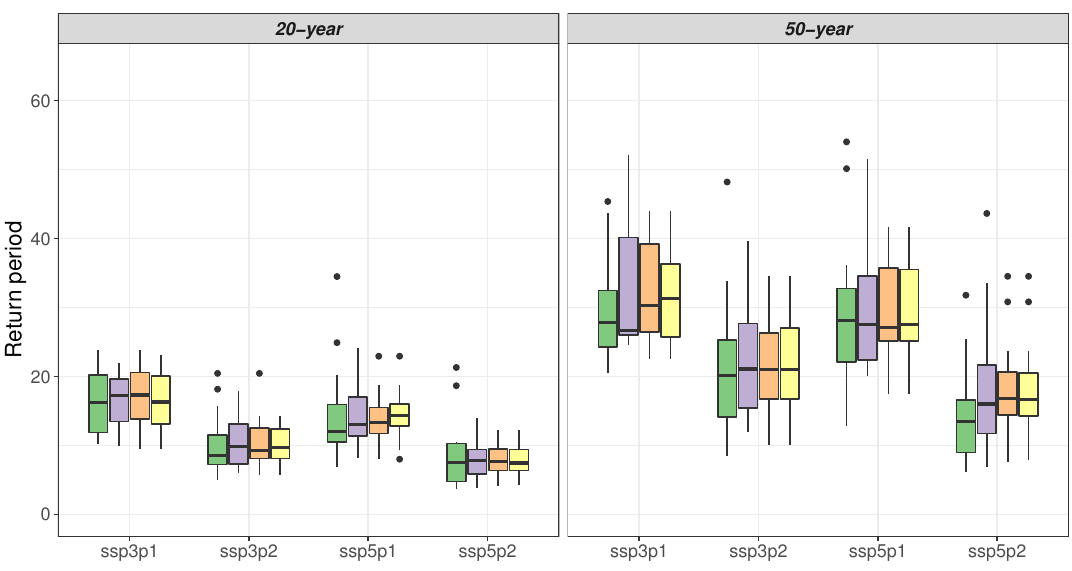
Figure 9. Same plots as in Figure 8 but for 20- and 50-year return periods relative to the observations from 1973 to